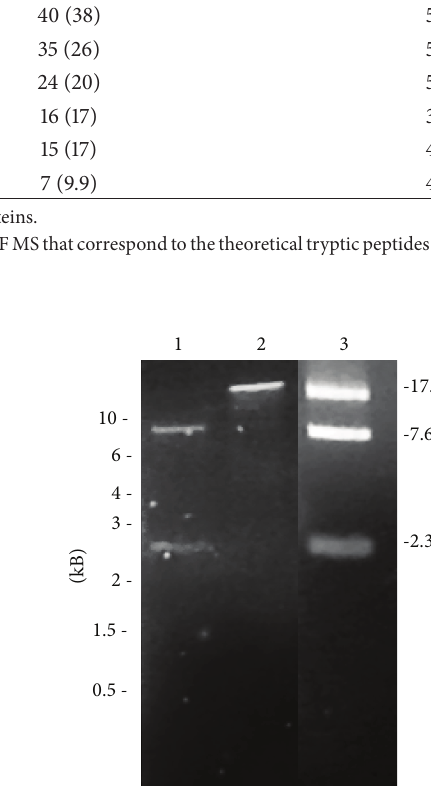
Figure 5: Detection of proteins bound to the termini of PH1 DNA. DNA was extracted from purified PH1 particles without proteinase K, digested with Ase I, then passed through a silica filter (GF/C) underconditionswhereproteinswouldbindtothefilter.Lane1: Ase I fragments that did not bind and were eluted. Lane 2: Ase I fragments that bound and were eluted only after protease treatment. Lane 3: Ase I digest of PH1 DNA. The positions of DNA size standards are indicated on the left side, in kb. The calculated sizes of the Ase I fragments of PH1 DNA in lane 3 are indicated on the right side (also in kb). The predicted 0.62 kb PH1 Ase I fragment was not